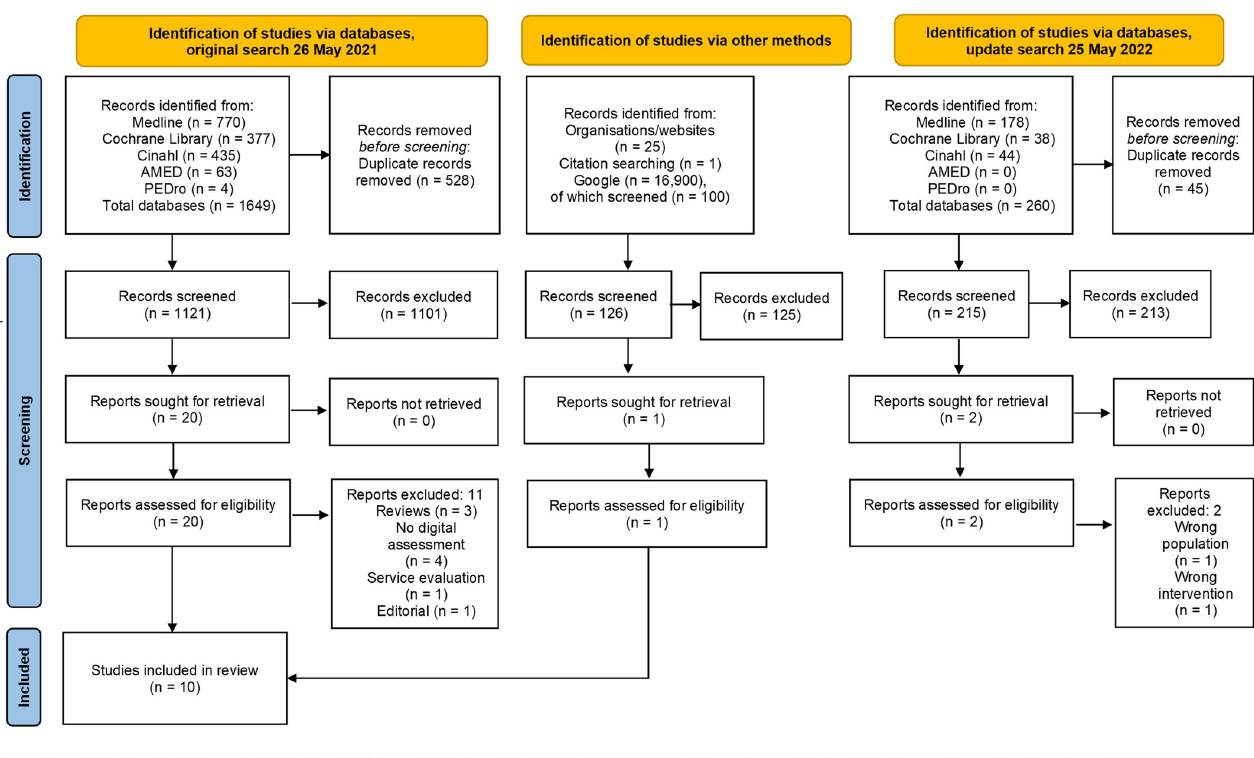
Fig 1. Flow diagram of literature searches and search